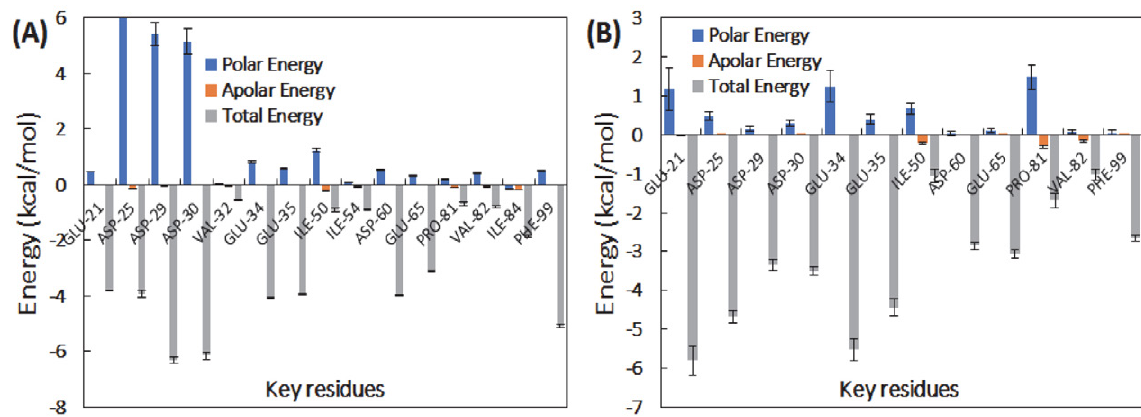
Fig. 11. (A) Polar, apolar and total energy contributions of the key residues of HIV-1 protease for binding of 11630770. (B) Polar, apolar and total energy contributions of the key residues of HIV-1 protease for binding of 55868948.